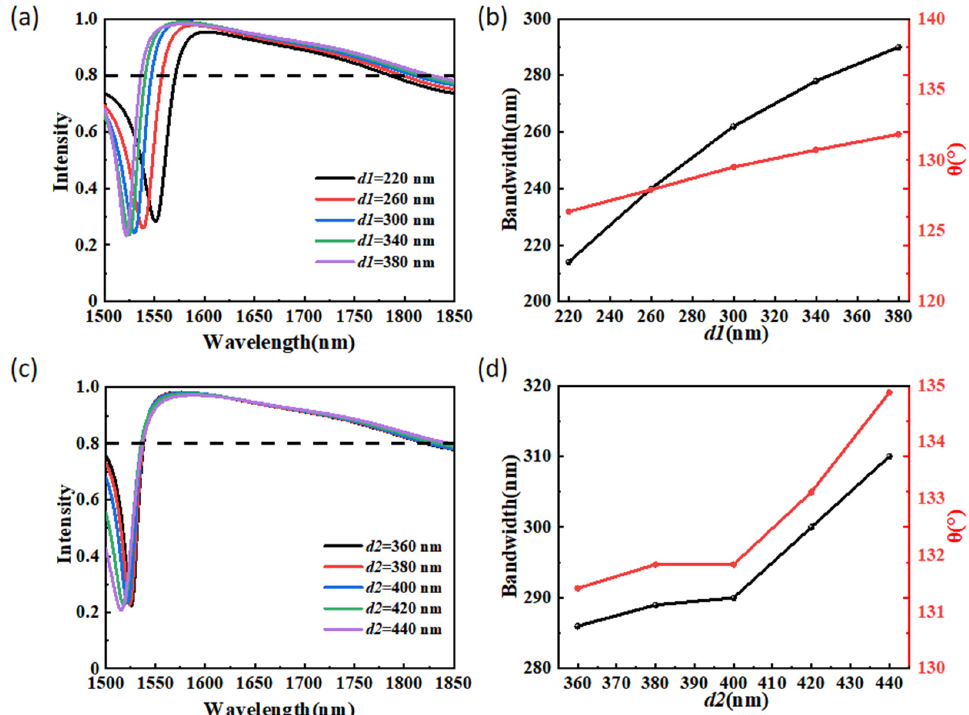
Figure 8. ( a ) The anomalous transmission intensity at different values of d1 within the range from 1500 nm to 1850 nm. ( b ) Operating bandwidth and the maximum beam split angle in the operating bandwidth as a function of d1 . ( c ) The anomalous transmission intensity at different values of d2 within the range from 1500 nm to 1850 nm. ( d ) Operating bandwidth and the maximum beam split angle in the operating bandwidth as a function of d2 . Table 1. Performances of the proposed structure and the previous reports based on discrete and quasi-continuous